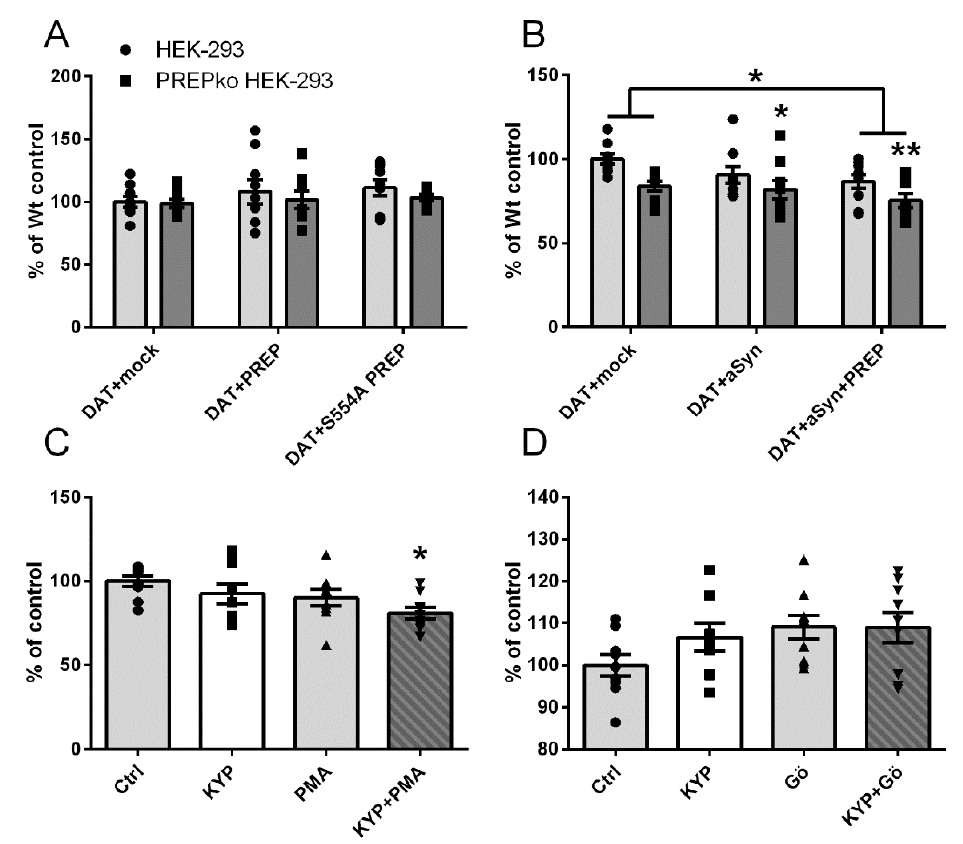
Figure 4. The effect of PREP on dopamine uptake in Wt and stable PREPko cells. Uptake of 3H-dopamine was measured in Wt and stable PREPko cells transfected with DAT and active or inactive PREP ( A ), or DAT and α -synuclein (aSyn) with or without PREP ( B ), and in DAT-transfected Wt cells that were treated 30 min with PREP inhibitor and PKC activator (PMA) or inhibitor (Gö-6983) ( C , D ). Cells were starved in serum-free media 2 h before treatment and then treated with 1 µ M KYP, 1 µ M PMA, or 1 µ M KYP + 1 µ M PMA for 30 min ( C ). Cells treated with 1 µ M KYP, 1 µ M Gö-9683, and 1 µ M KYP + 1 µ M Gö-6983 for 30 min were not starved ( D ). Data were from three independent experiments for cells with three biological replicates. Bars represent mean ± SEM. * p < 0.05, ** p < 0.01, one-way ANOVA or two-way ANOVA, Tukey ´ s post-hoc test.